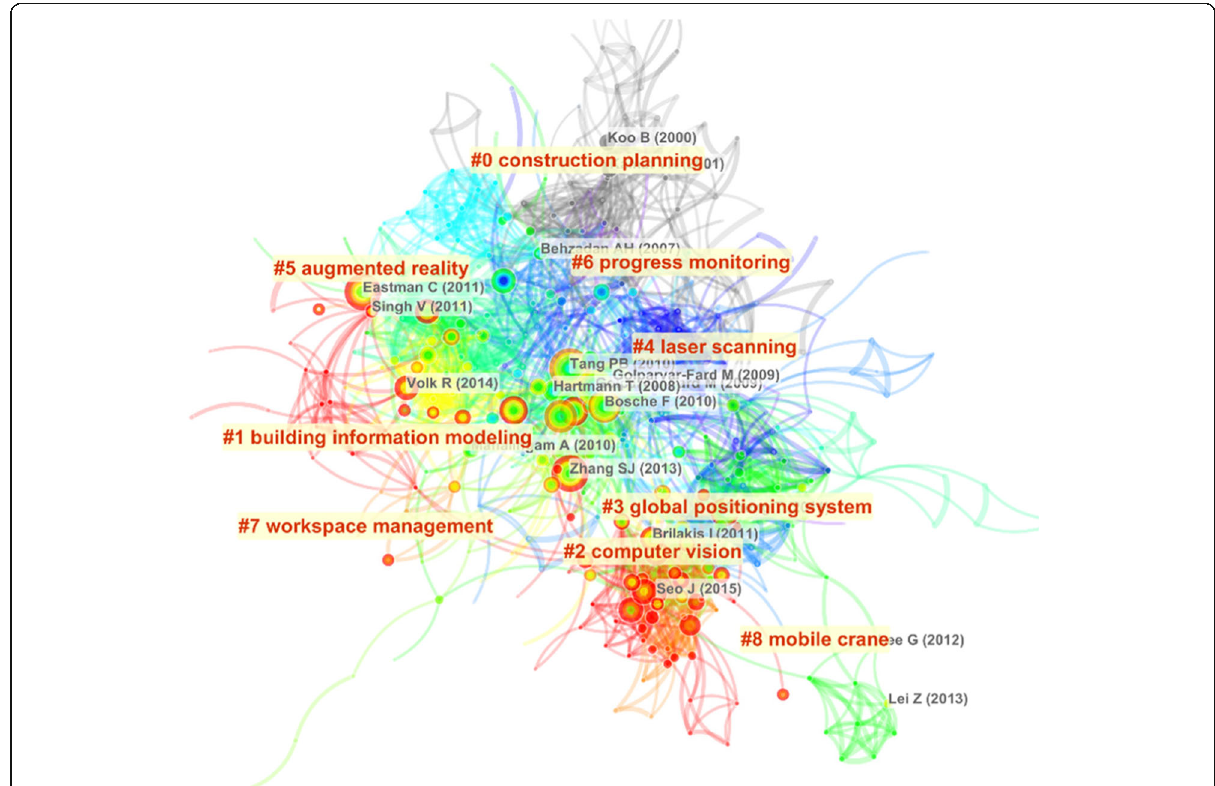
Fig. 3 A landscape view of the co-citation